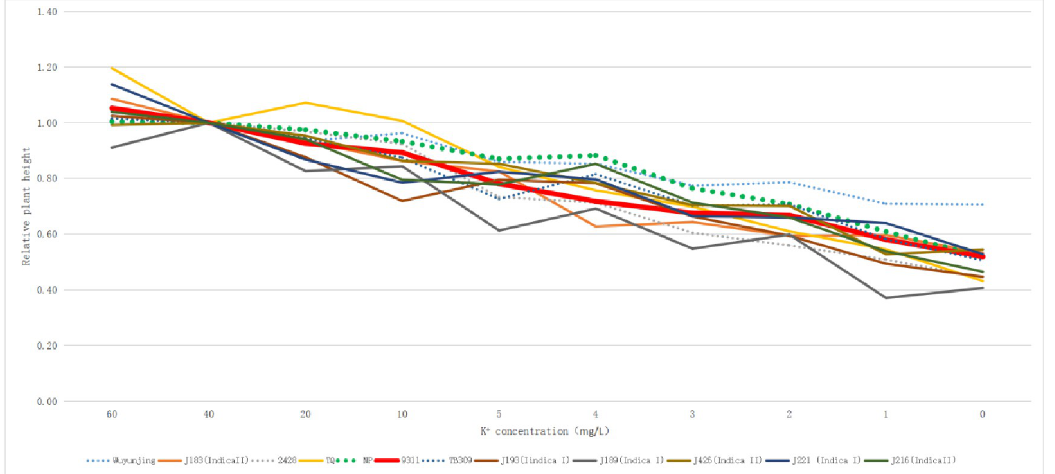
Fig 1. Relative plant height of twelve rice varieties in different potassium concentration culture solution. The dotted line is japonica rice and the solid line is indica rice.